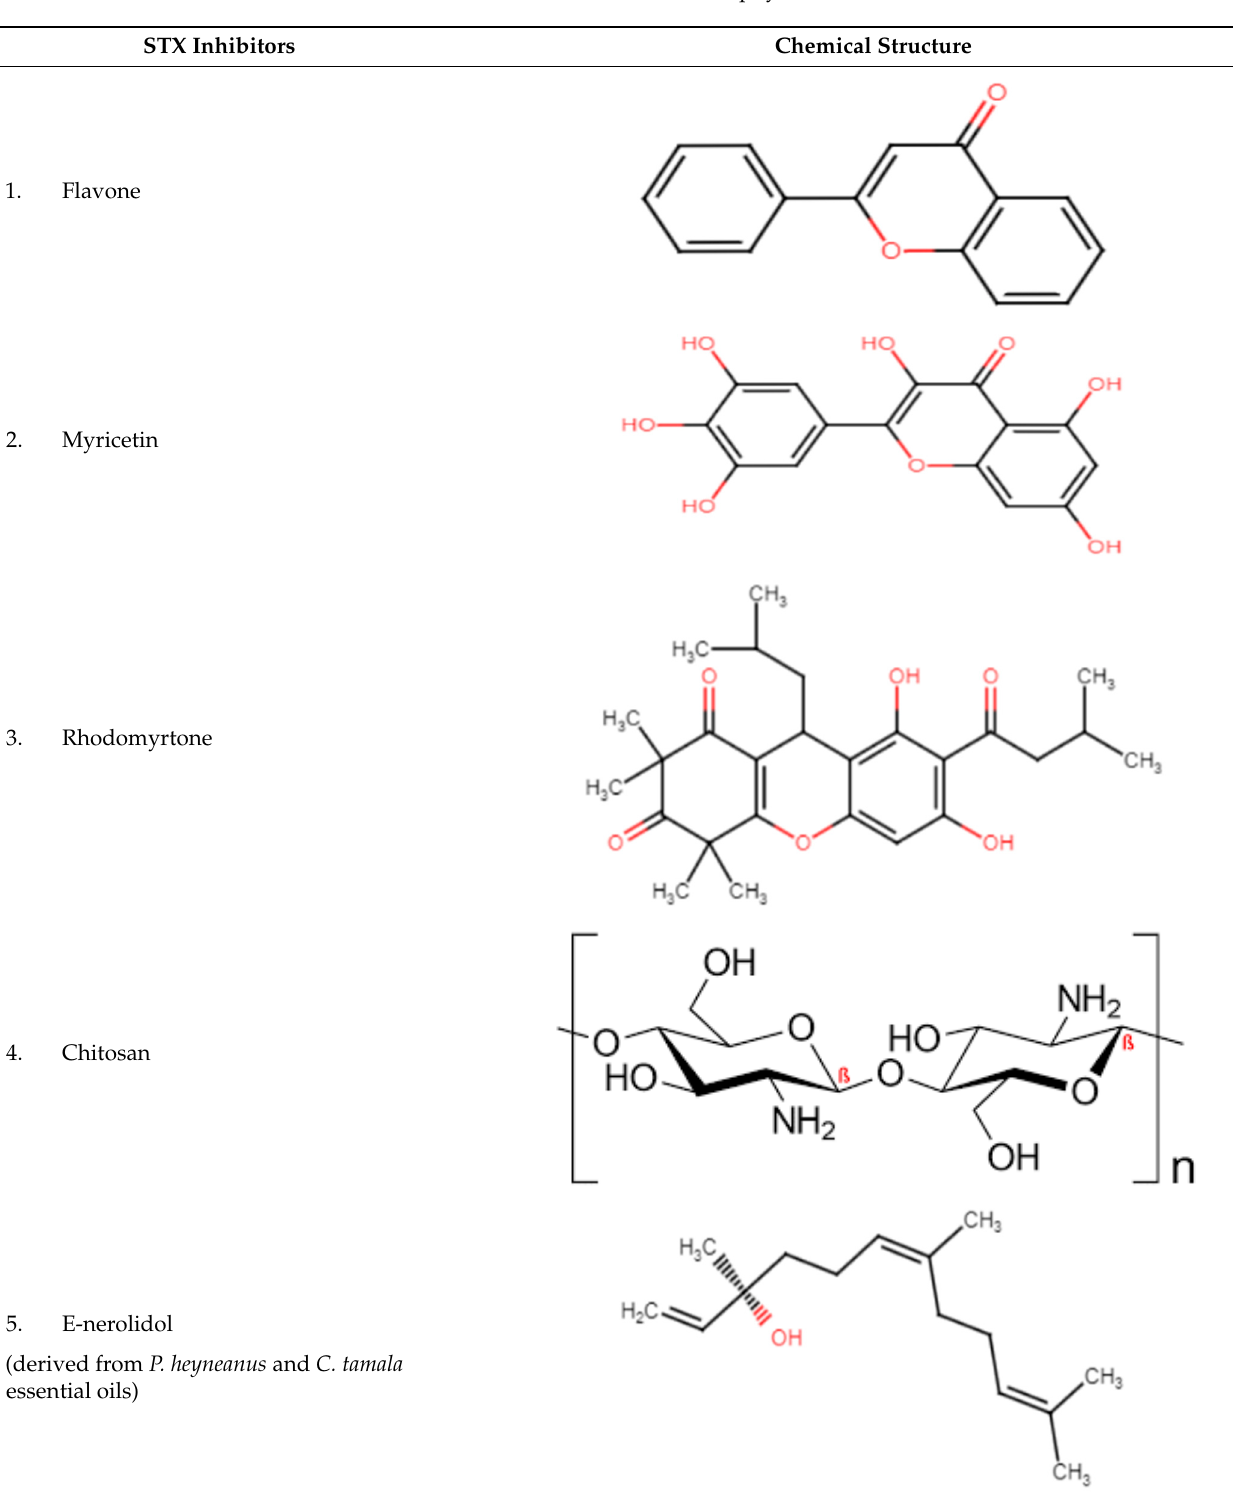
Table 1. Chemical structures of various staphyloxanthin inhibitors.